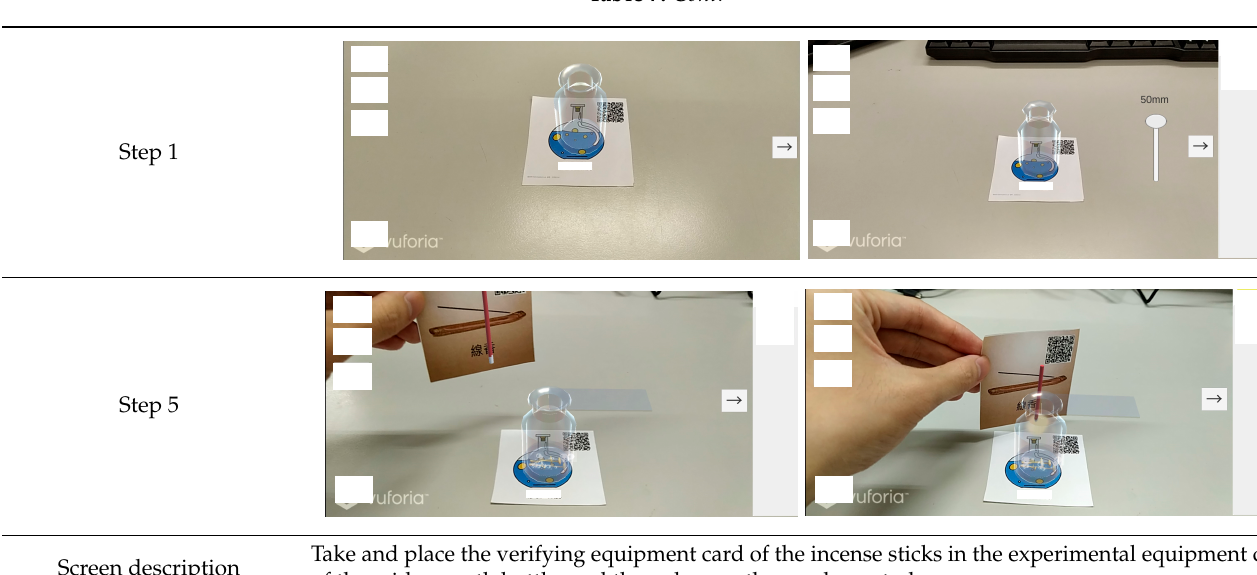
Table 7. Steps of operating the oxygen production experiment.